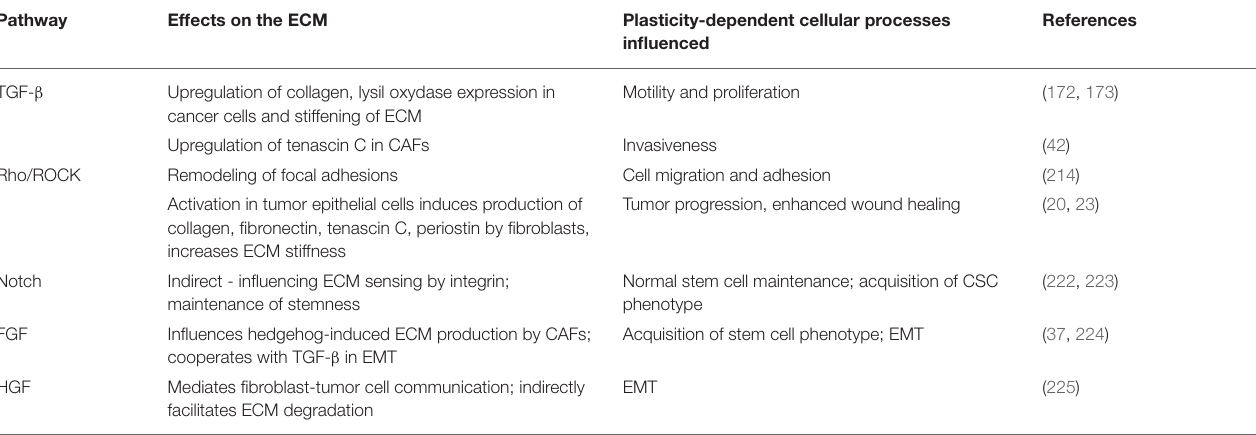
TABLE 2 | Molecular regulators of the ECM and cancer cell plasticity.